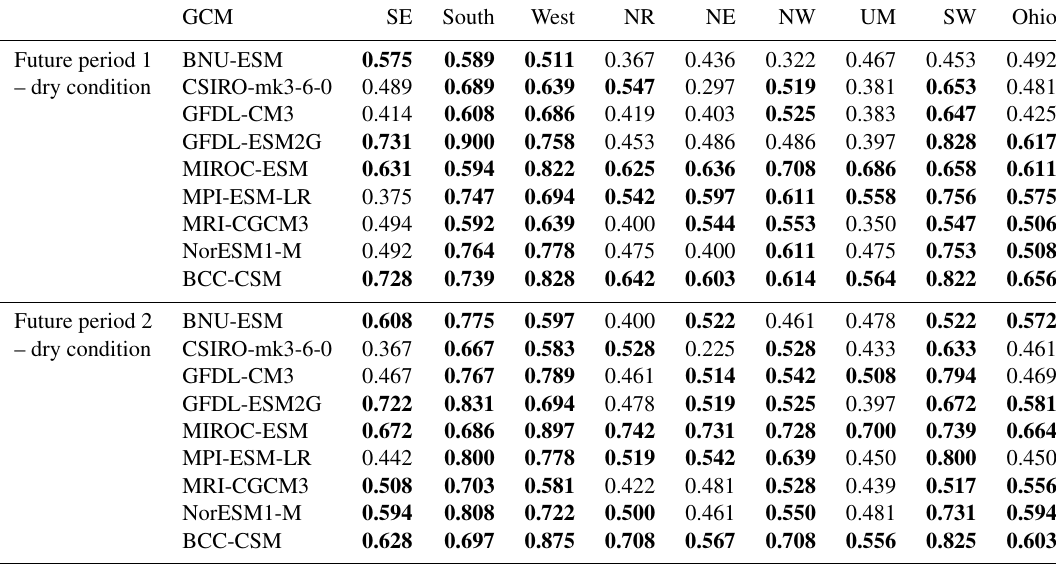
Table 4. The fraction of future dry conditions over all months by GCMs (future periods 1 and